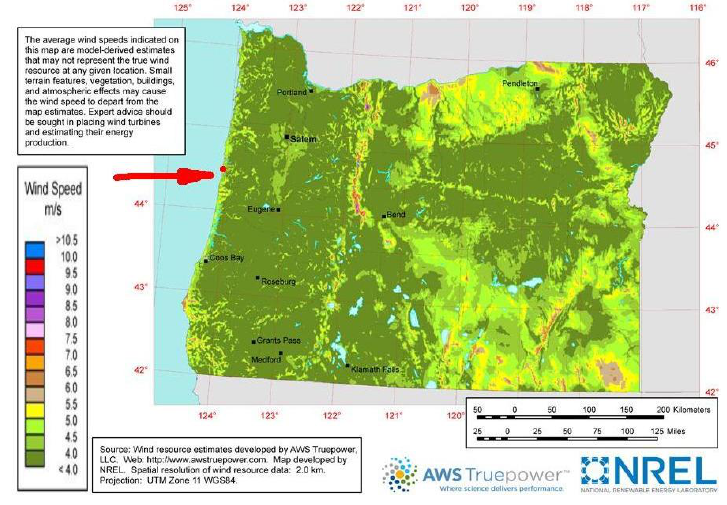
Figure 8. Average annual wind speed of Oregon at 30